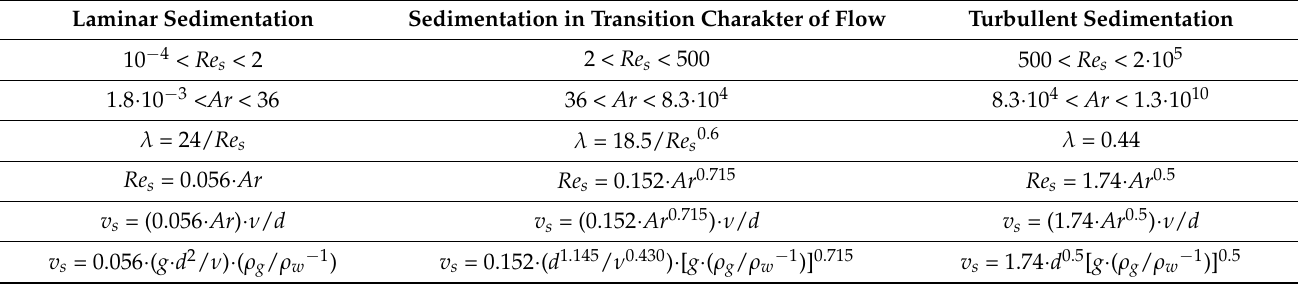
Table 1. Equations describing the free sedimentation velocity v s of the single solid phase grain in water as a function of Re s and Ar